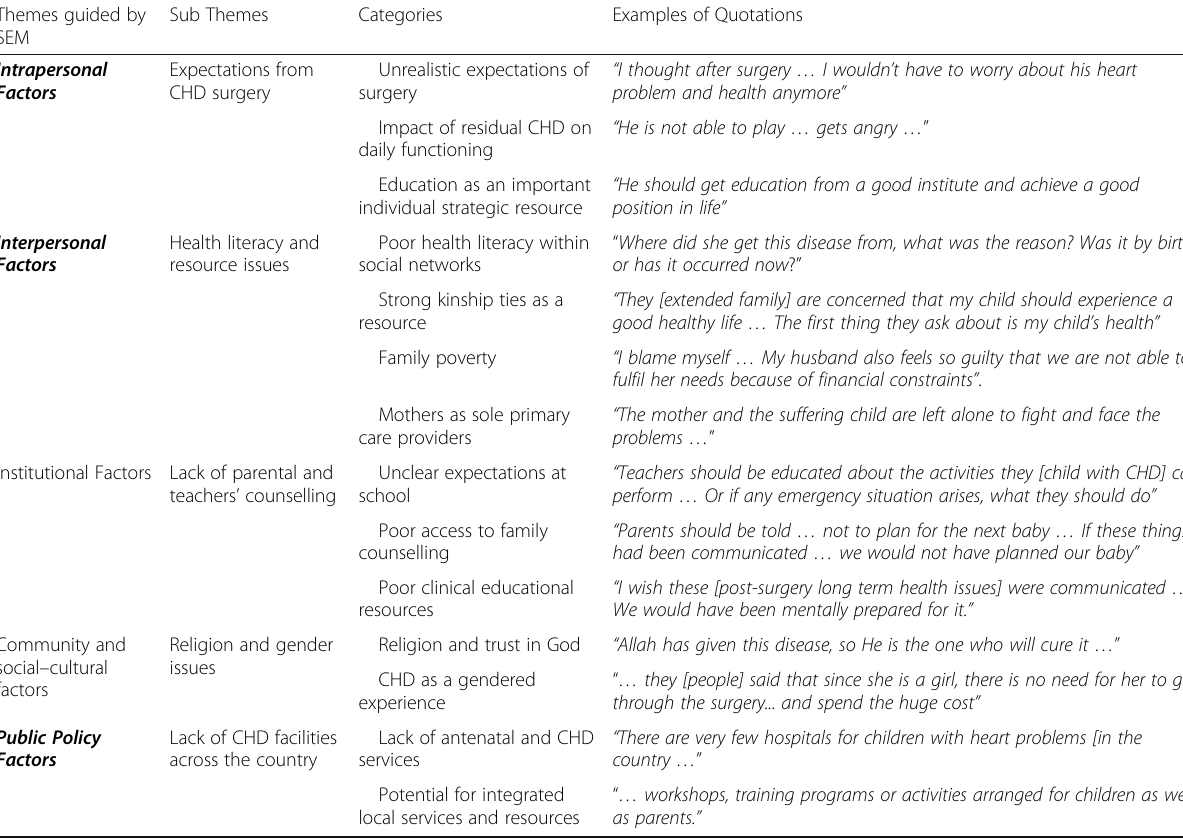
Table 3 Coding process framework using the domains of the Social Ecological Model [11] Themes guided by